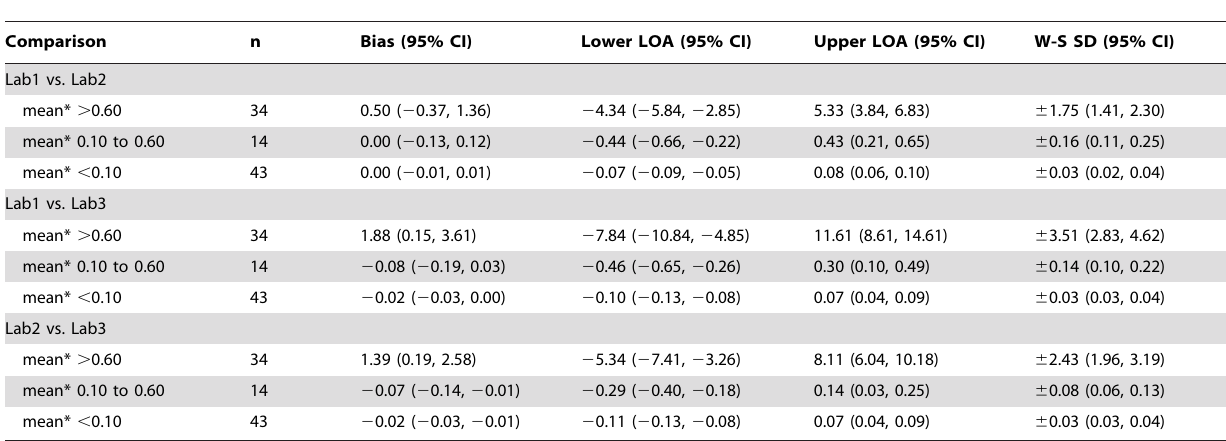
Table 6. W-S SD, bias, and LOA in three strata based on the mean TB Response for Lab1, Lab2, and Lab3.